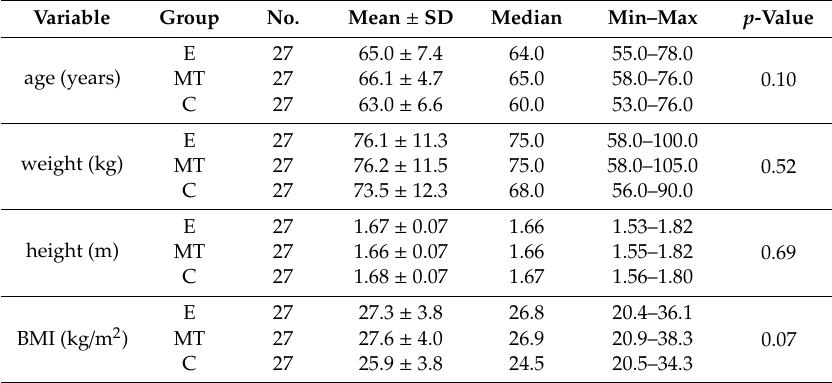
Table 1. Main anthropometric data of the study population (only included